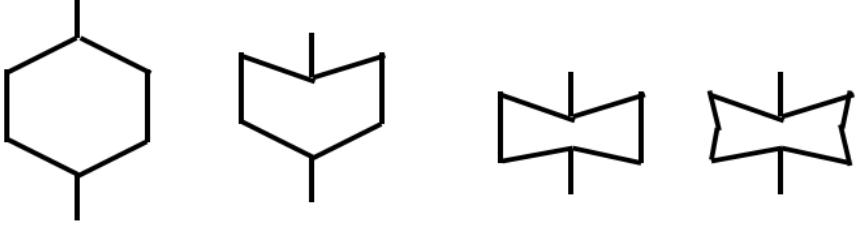
Figure 17. Radial deformation—theoretical analysis.